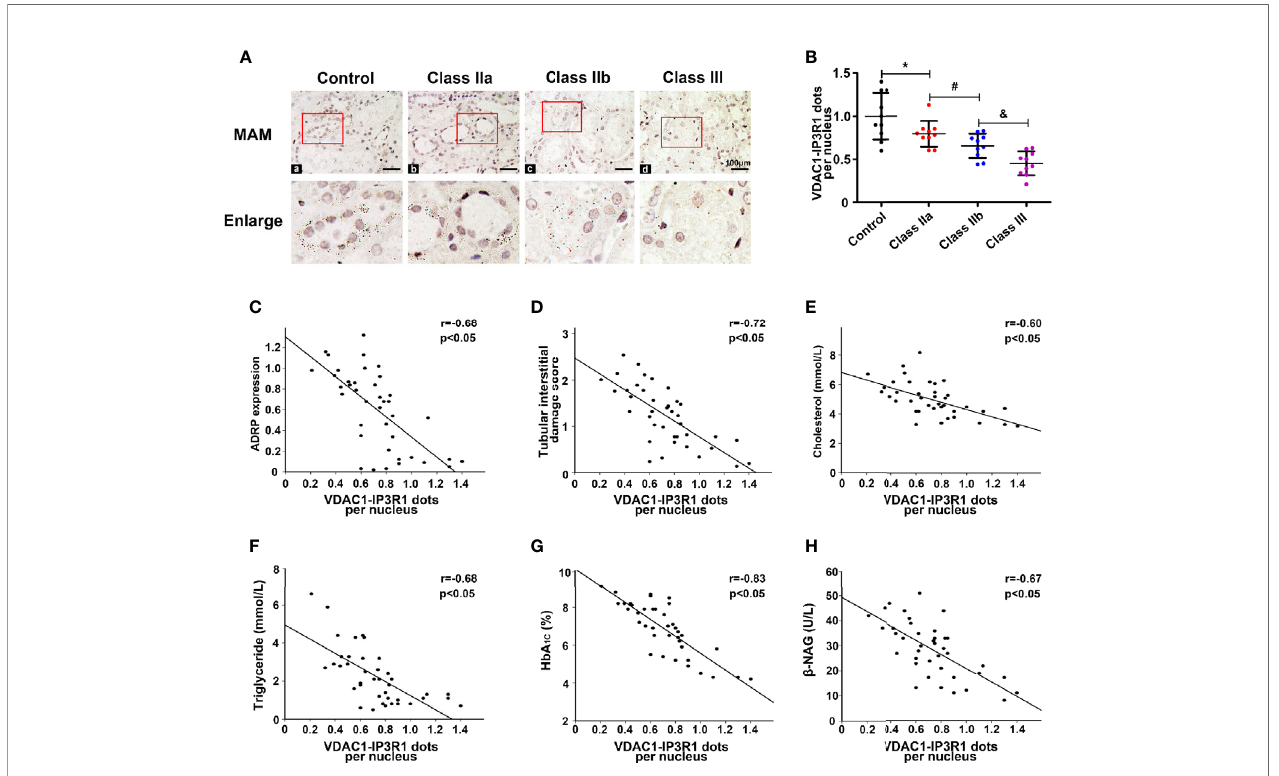
FIGURE 3 | Disruption of MAM coupling in DN patients and the correlation between the MAMs, lipid deposition, and kidney injury. One-way ANOVA was used to compare the differences among groups, and the correlation of two numerical variables was tested by Pearson ’ s analysis. (A) A signi fi cant decrease in MAMs was observed in the kidneys of the DN groups compared with the control. (B) Scatter diagram representing the level of the MAMs. Correlation analysis between the MAMs and the expression of ADRP (C) , tubular interstitial damage score (D) , CHOL level (E) , TG level (F) , HbA1c level (G) , and b -NAG level (H) . Experiments were performed at least three times for each donor, with a minimum of fi ve random fi elds taken per condition. Values are the mean±SD. *p < 0.05 compared with the control group; # p < 0.05 compared with the class IIa group; & p < 0.05 compared with the class IIb